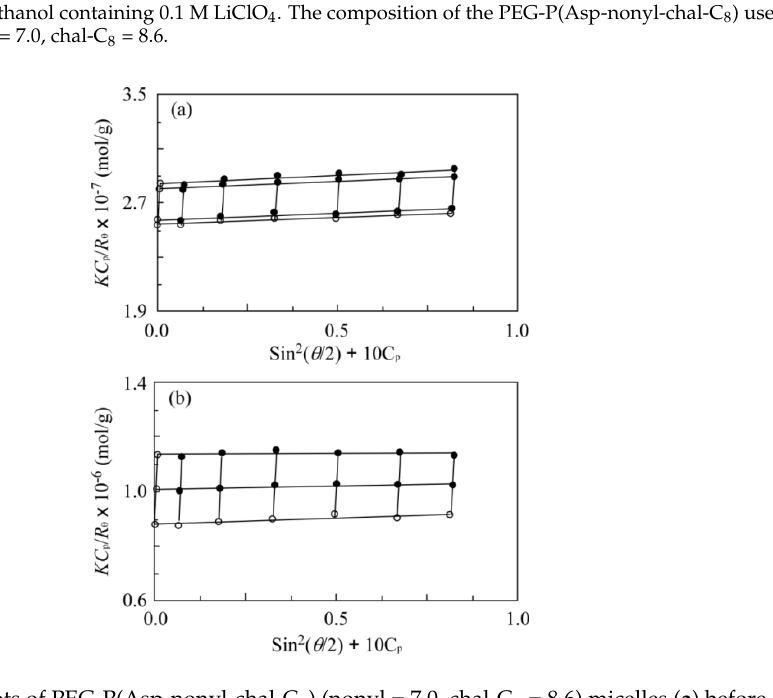
Figure 3. Zimm plots of PEG-P(Asp-nonyl-chal-C 8 ) (nonyl = 7.0, chal-C 8 = 8.6) micelles ( a ) before and ( b ) after photo-crosslinking; and ( a ) in normal saline and ( b ) in methanol containing 0.1 M LiClO 4 .